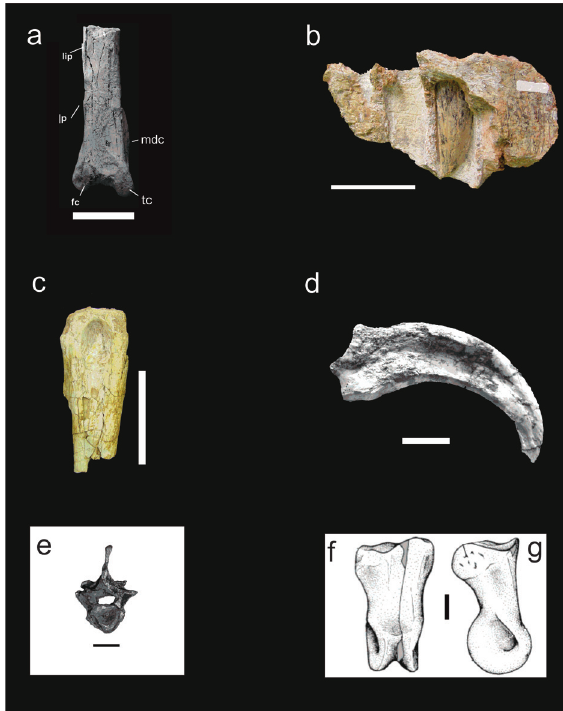
Figure 4 - Holotypic material of five sauropod species from the Bauru Group. a – Baurutitan britoi Kellner et al. 2005, where a1 and a2 are the caudal and the haemal arch sequences in right lateral views (scale = 10cm). b – Trigonosaurus pricei Campos et al. 2005, where b1 is the cervical and dorsal elements preserved; b2 is the sacrum, and b3 is the caudal sequence preserved (scales = 10cm). c – Maxakalisaurus topai Kellner et al. 2006, where: c1 – right maxilla in lateral ( a ), medial ( b ), occlusal ( c ) and tooth detail ( d ) views (scale = 1cm); c2 – third cervical vertebra in right lateral view; c3 – Mid-cervical vertebra (7 th ?) in left lateral view; c4 – Mid-posterior cervical vertebra (10 th ?) in right lateral view; c5 – cervical rib of mid-posterior cervical vertebra in lateral view; c6 – cervical rib of mid-cervical vertebra in lateral view; c7 – anterior dorsal vertebra (3 rd ?) in right lateral view; c8 – right sacral rib in anterior view; c9 – anterior caudal vertebra in anterior view; c10 – mid-caudal vertebra in right lateral view; c11 and c12 – posterior caudal vertebra in right lateral view; c13 – Haemal arch in posterior (a) and left lateral (b) views; c14 – sternal plate; c15 – right humerus in anterior view; c16 – Metacarpals IV (a) and II (b) in anterior view; c17 – right ischium in lateral view; c18 – left fibula in anterior view; c19 (a) and (b)– two osteoderms in internal view ; c20 – osteoderm in external view (c2 – c20 scales = 10cm). Abbreviations of d: cpol, centropostzygapophyseal lamina; cprl, centroprezygapophyseal lamina; eprl, epipophyseal-prezygapophyseal lamina; pcdl, posterior centrodiapophyseal lamina; pcpl, posterior centroparapophyseal lamina; podl, postzygodiapophyseal lamina; posl, postspinal lamina; prdl, prezygodiapophyseal lamina; prsl, prespinal lamina; spd, spinodiapophyseal lamina; spol, spinopostzygapophyseal lamina; sprl, spinoprezygapophyseal lamina; tpol, intrapostzygapophyseal lamina; tprl, intraprezygapophyseal lamina. More details in Machado et al. (2013). Figure by F.